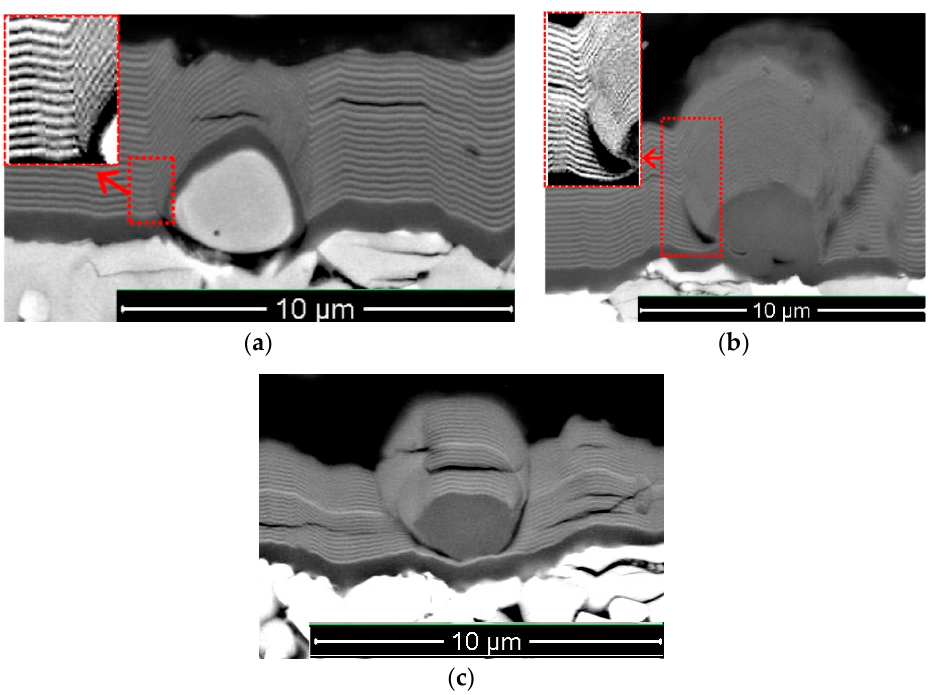
Figure 3. Examples of the influence of microdroplets on the structure of the ( a , b ) Ti–TiN–(Ti,Cr,Mo,Al)N and ( c ) Ti–TiN–(Ti,Nb,Zr,Al)N coatings (SEM 1).